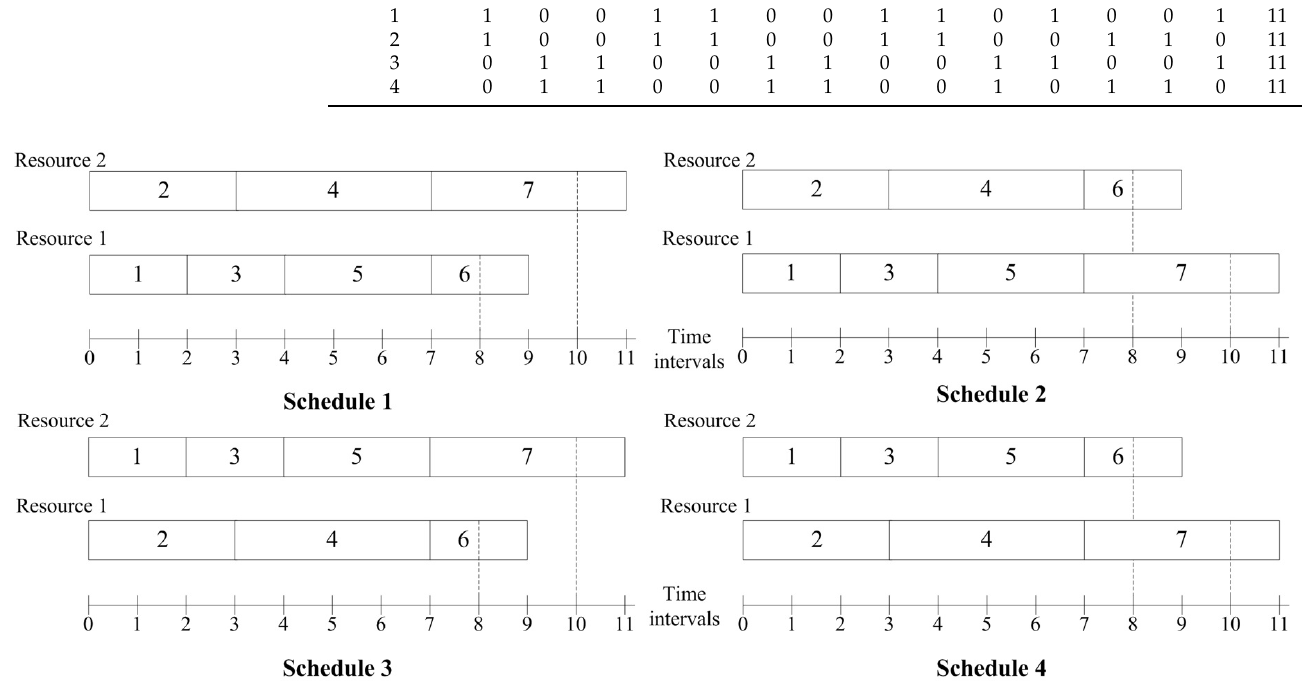
Figure 1. Schedules received by the Y. A. Mezentsev method with the minimum makespan.